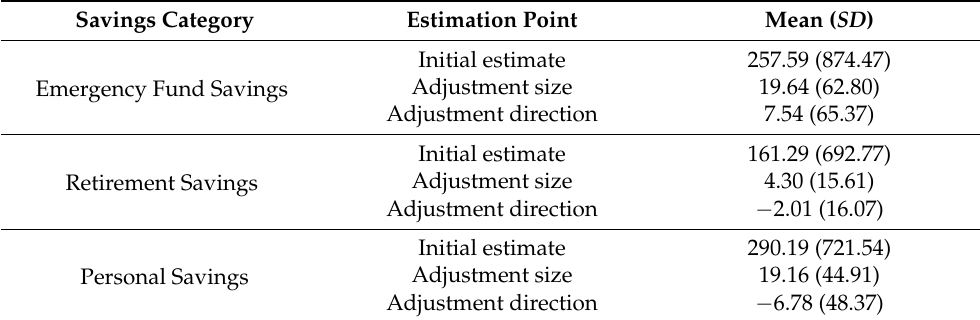
Table 3. Means of initial estimates and post-scenario adjustments of the different categories of